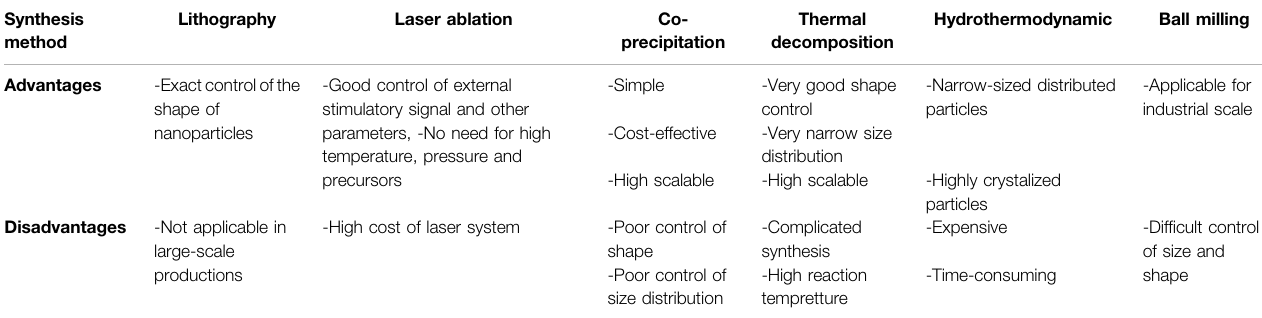
TABLE 1 | Various methods for magnetic nanoparticles synthesis and their